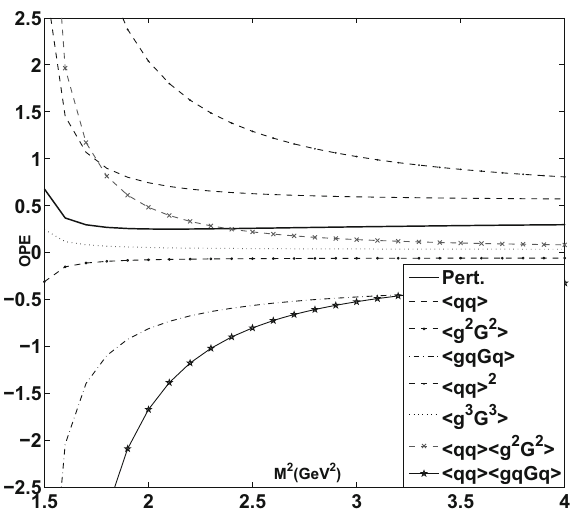
0 . 88 ± 0 . 25 GeV 4 , and (cid:4) g 3 G 3 (cid:5) = 0 . 58 ± 0 . 18 GeV 6 [36– 38,40]. Steering a middle course, the factorization parameter (cid:6) is set to be 2. According to a standard procedure, both the OPE convergence and the pole dominance should be con- sidered to find appropriate work windows for the thresh- √ s 0 and the Borel parameter: the lower bound of M 2 old is gained by analyzing the OPE convergence, and the upper one is obtained by viewing that the pole contribution should be larger than QCD continuum contribution. Besides, characterizes the beginning of continuum states and should not be taken at will. It is correlated to the next excited state energy and empirically 400 ∼ 600 MeV above the eventually achieved value M H